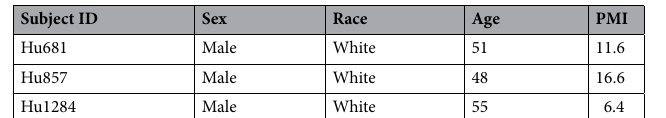
Table 1. Demographic information of subjects from which postmortem human brain samples were obtained. PMI = postmortem interval between which subjects were deceased and samples were harvested measured in